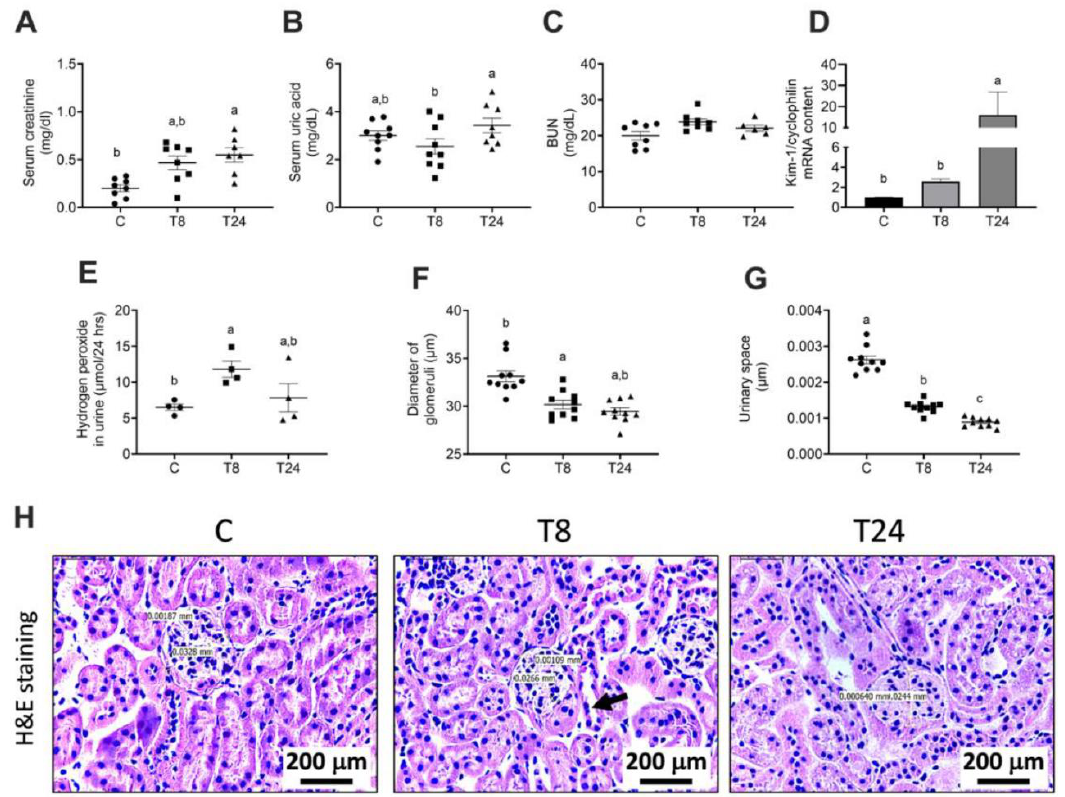
Figure 1. Renal functional alterations associated with endoplasmic reticulum (ER) stress. Mice were administered a single i.p. injection of vehicle or tunicamycin (1 g/Kg body weight), and kidneys were obtained after 8 h (T8) or 24 h (T24). The following graphs display: serum creatinine ( A ), serum uric acid ( B ), BUN ( C ), Kim-1 gene expression ( D ), urinary hydrogen peroxide ( E ), morphometric analysis of glomerular diameter ( F ) and urinary space ( G ) in kidney sections stained with H&E (20 × magnification). Values are means ± SEM, n = 4–6. Means without a common letter differ significantly, a > b > c ( p < 0.05). ( H ) Representative micrographs of kidney H/E-stained sections from the different groups, in comparison with the control group ( c ), glomeruli are smaller in T8 and T24 groups, kidney from T8 group shows some proximal cortical tubules revisited by the flat damaged epithelium without apical microvilli (arrow), while kidney from the T24 group exhibits numerous tubular epithelial cells with lipid cytoplasmic vacuoles